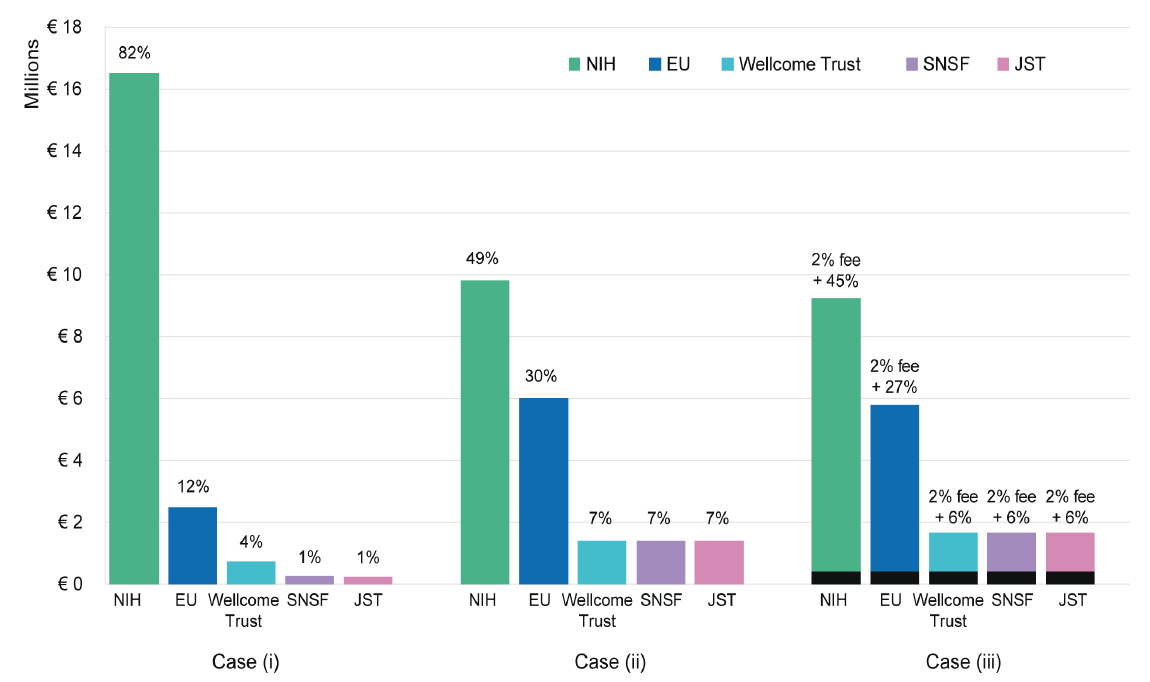
Figure 3. Distribution of the UniProt cost among the 5 funding agencies with the 3 variations of the Infrastructure Model . Case (i) is the classic model, in which the cost is covered by 0.1% of life science budget of each agency. In Case (ii), the five funding agencies are classified depending on their life science spending and total cost is shared among the categories with different percentages, but constant inside each group. In Case (iii) a fixed 2% entry fee is required from each funder (irrespective of the size) and the rest of the cost is covered by a contribution depending on the classification (S - M - L), as in Case